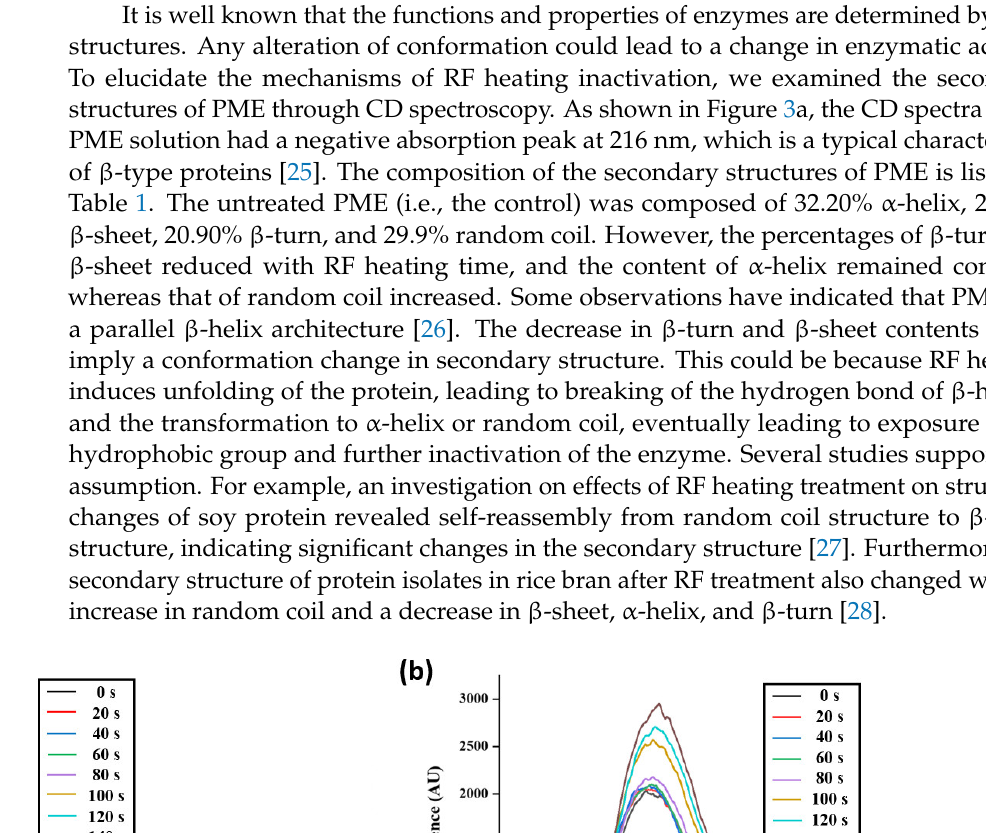
Table 1. Composition of the secondary structures of PME (%).